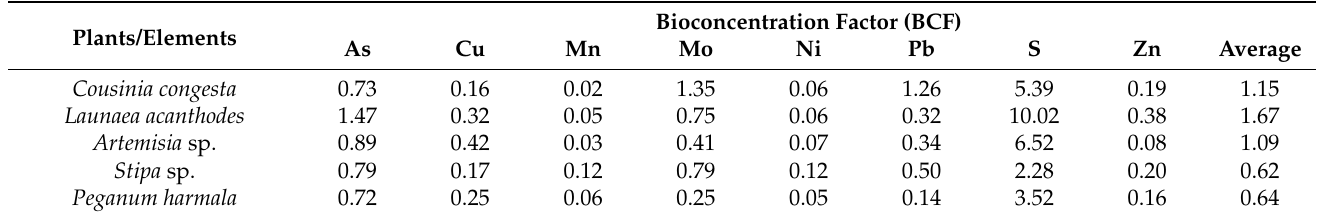
Table 5. The bioavailability index of the sampled native plants for the most polluted station of the different elements.